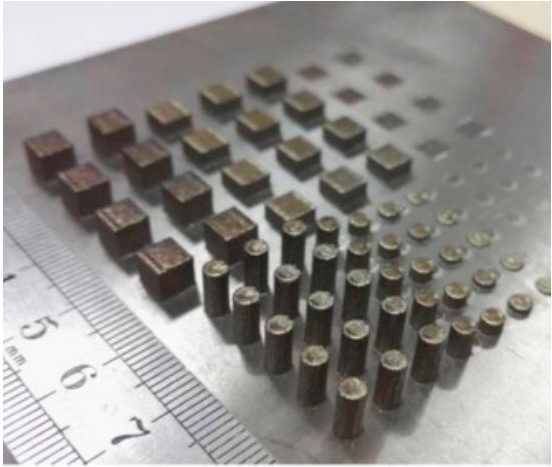
Figure 21. 3D-printed Zr-based BMG samples (adapted with permission from reference [58]).